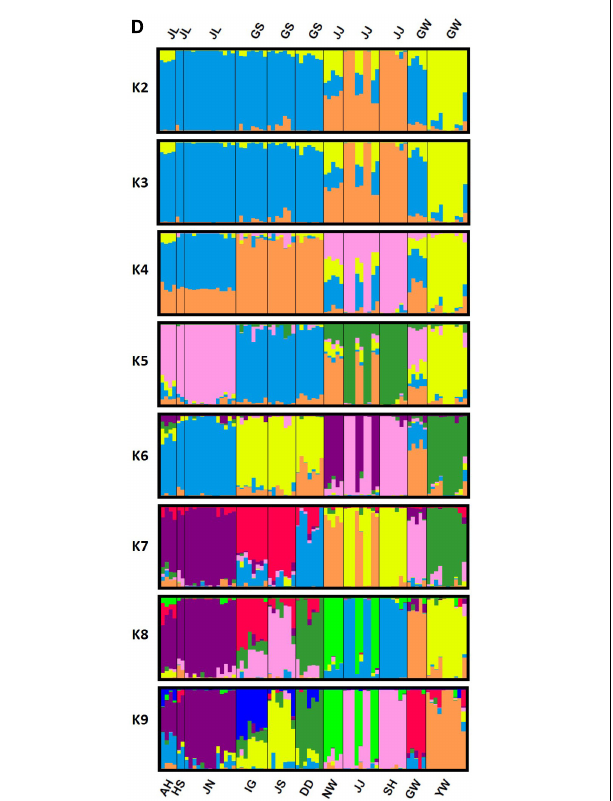
FIGURE 3 | Bayesian model-based assignment analysis of 2,734 SNPs for 10 populations of Habenaria linearifolia and one population of Habenaria cruciformis . Pie charts on the map show the frequency of each cluster in a population. See Table 1 for abbreviations of population locations and sample sizes. (A) K2, the best K plot; (B) K3 plot; (C) K9 plot; and (D) K2–K9 bar plot. Populations are separated by vertical black